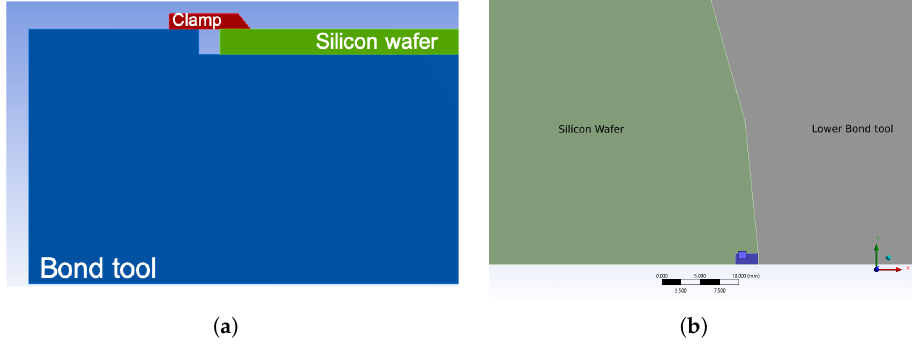
Figure 18. Bond tool clamps: ( a ) bond tool clamp configuration on the wafer; ( b ) zero degree of freedom area (blue) in the FE model (x-y